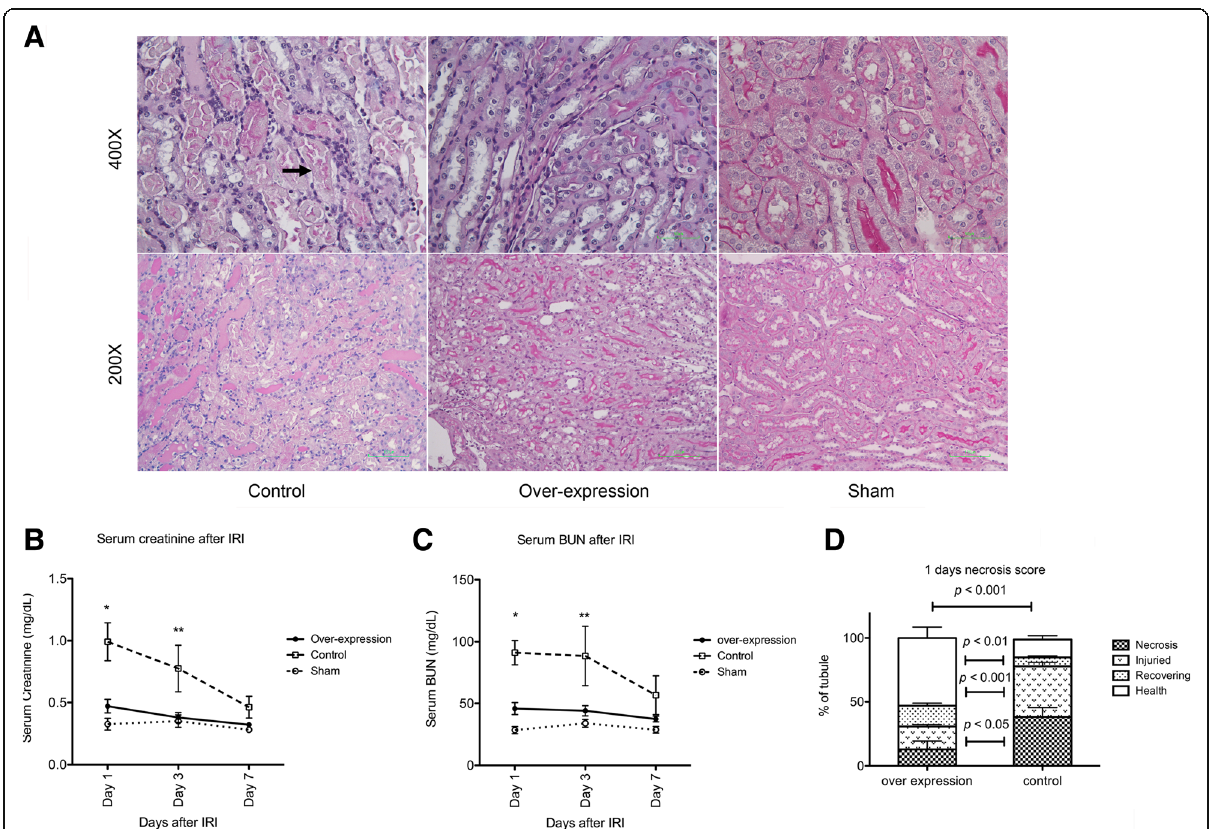
Fig. 7 a PAS staining of renal tissue 1day after IRI in control and over expression mice. The tubular necrosis was less prominent in the over expression mice 1days after IRI. Arrow indicates necrotic tubule. b Serum creatinine level in the control and over expression mice 1, 3 and 7days after IRI. The serum creatinine level was lower in the over expression mice 1 and 3days after IRI. ( N =19 in the control group, N =23 in the over-expression group, N =5 in the sham mice, * P =0.004, ** P =0.015) c Serum BUN level in the control and over mice expression 1, 3 and 7days after IRI. The serum BUN level was lower in the over expression mice 1 and 3days after IRI. ( N =19 in the control group, N =23 in the over-expression group, N =5 in the sham mice, * P< 0.001, ** P =0.016) d Semi-quantitative analysis of tubular necrosis 1day after IRI in the control and over expression mice. The tubular necrosis score was less in the over expression mice. ( N =19 in the control group, N =23 in the over-expression group, N =5 in the sham